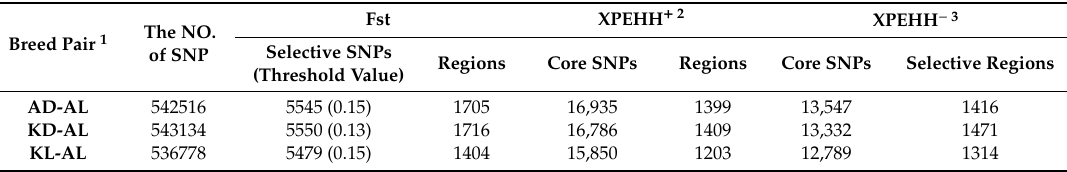
Table 1. The statistics of selection signatures and selective regions in three population pairs obtained by Fst and